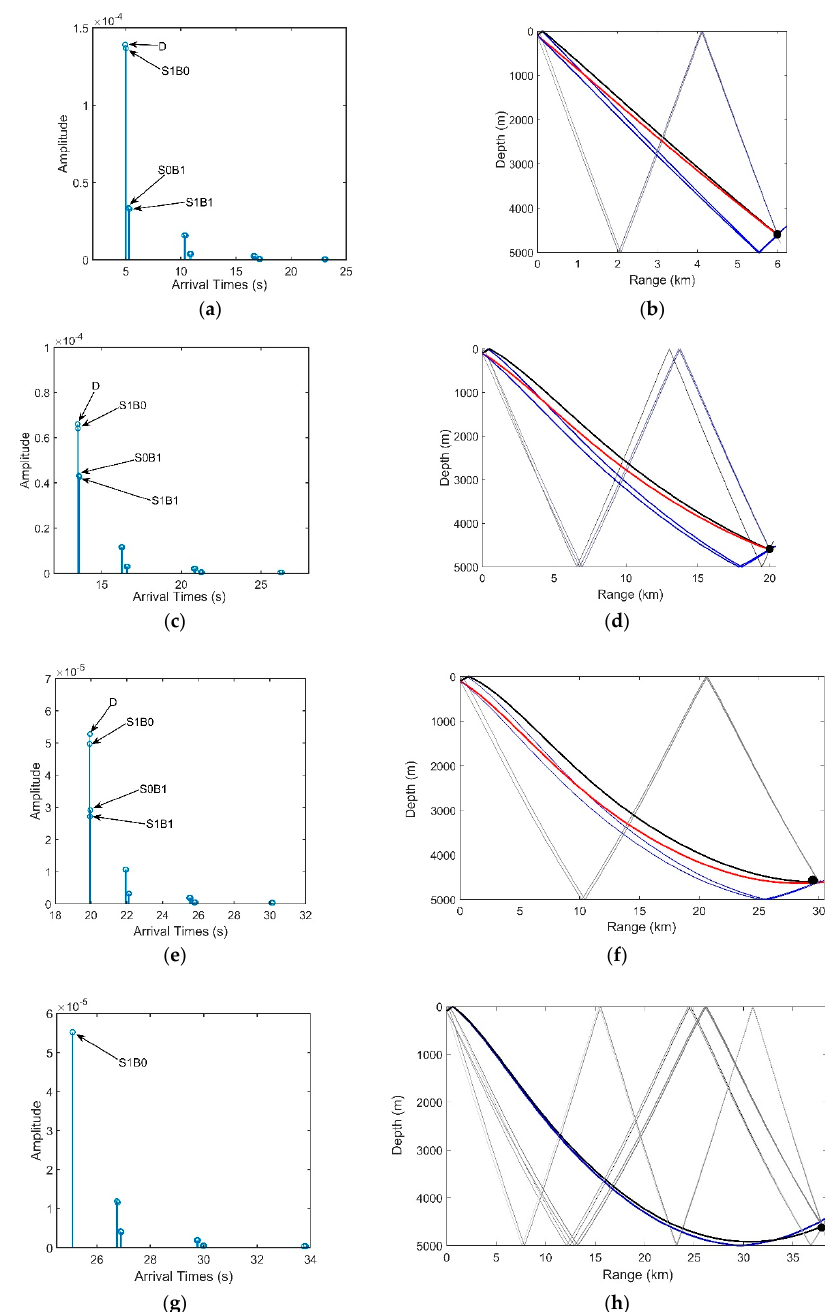
Figure 7. Arrival structures for the horizontal ranges of ( a , b ) 6 km, ( c , d ) 20 km, ( e , f ) 30 km and ( g , h ) 38 km.